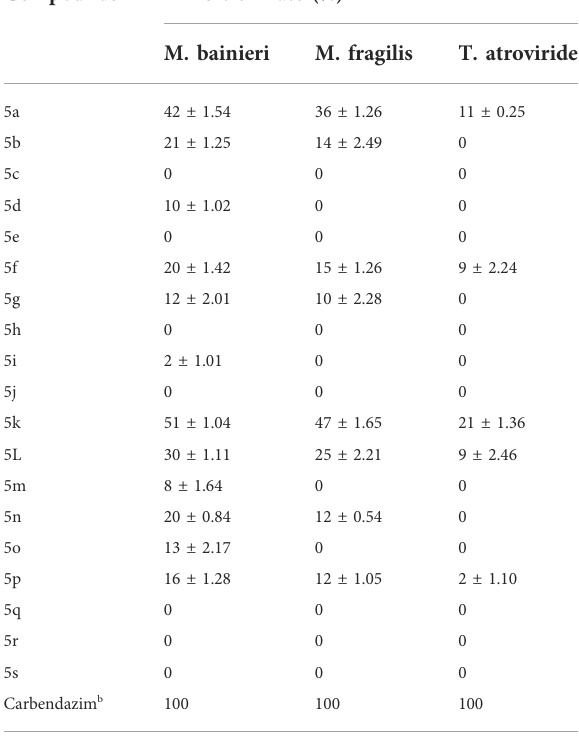
TABLE 3 In vitro antifungal activity test of compounds 5a − 5s against M. bainieri, M. fragilis, and T. atroviride. Compounds Inhibition rate (%)